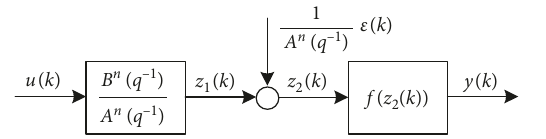
Figure 1: The structure of the Wiener model with internal